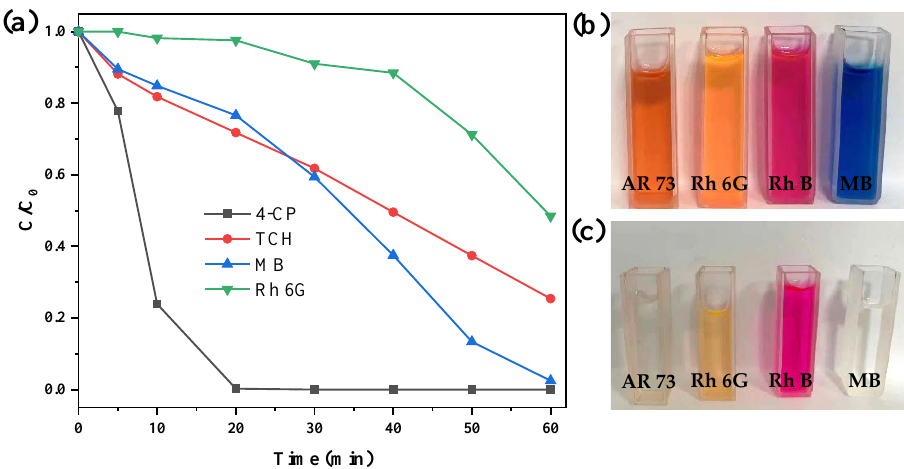
Figure 8. ( a ) Degradation of AR 73 by CS-Fe-2; ( b ) the color of different dyes before degradation; ( c ) the color of different dyes after degradation (dyes: 50 mg/L; CS-Fe-2 dosage: 1 g/L; H 2 O 2 dosage: 20 mM, time: 60 min; no pH adjustment).